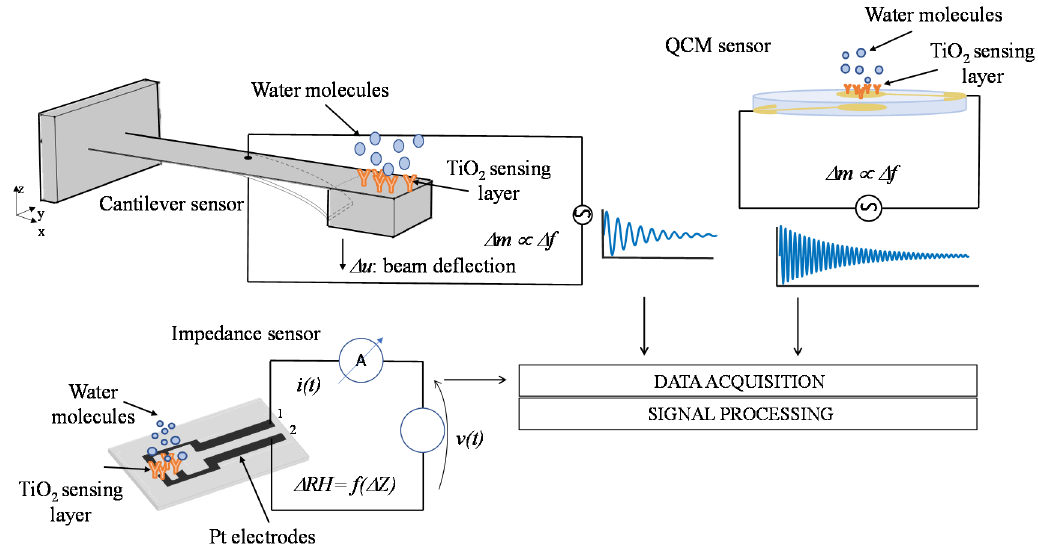
Figure 8. Schematic representation of the humidity measurement methods based on functionalized high-frequency Quartz Crystal Microbalance (QCM), low-frequency MEMS cantilever sensors, and impedance sensor.